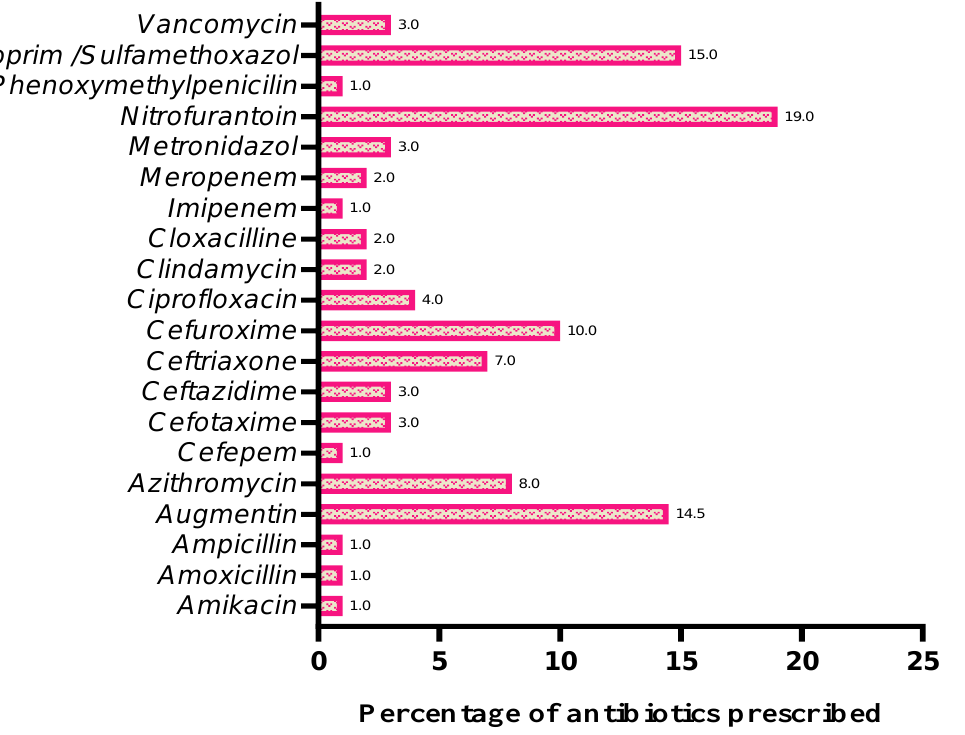
Figure 3. Percentage of antibiotics prescribed between May 2017 and April 2018 .